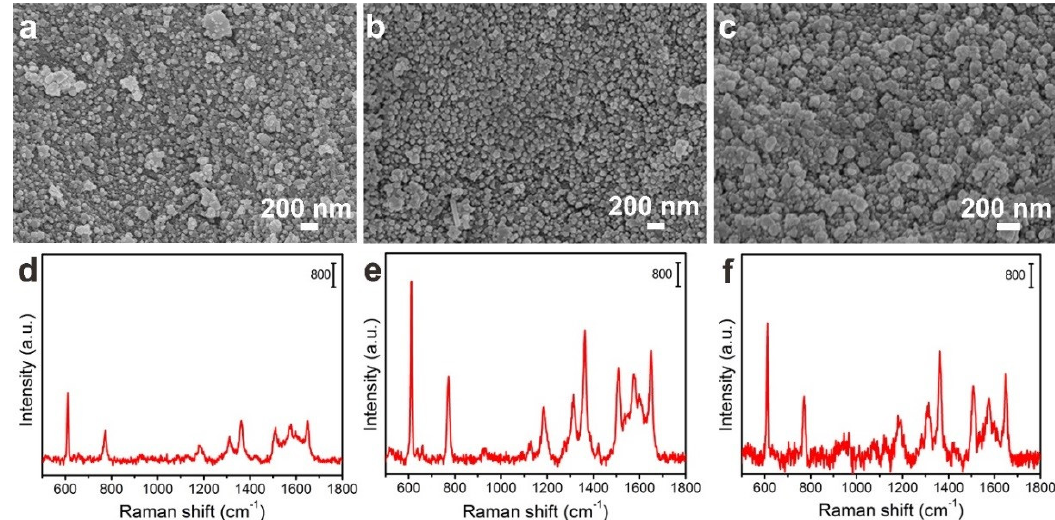
Figure 5. Images of AgNPs on FP@PDA with different reaction times: ( a ) 4 h, ( b ) 8 h and ( c ) 12 h. ( d – f ) SERS spectra of Rhodamine 6G (R6G) (10 − 6 M) collected for the corresponding 4h, 8h and 12h